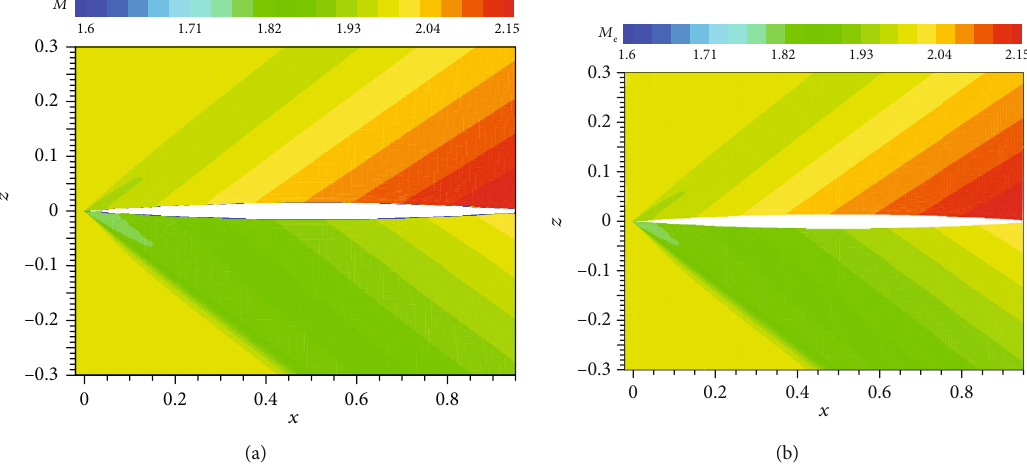
Figure 11: Comparison between (a) local Mach number and (b) predicted M